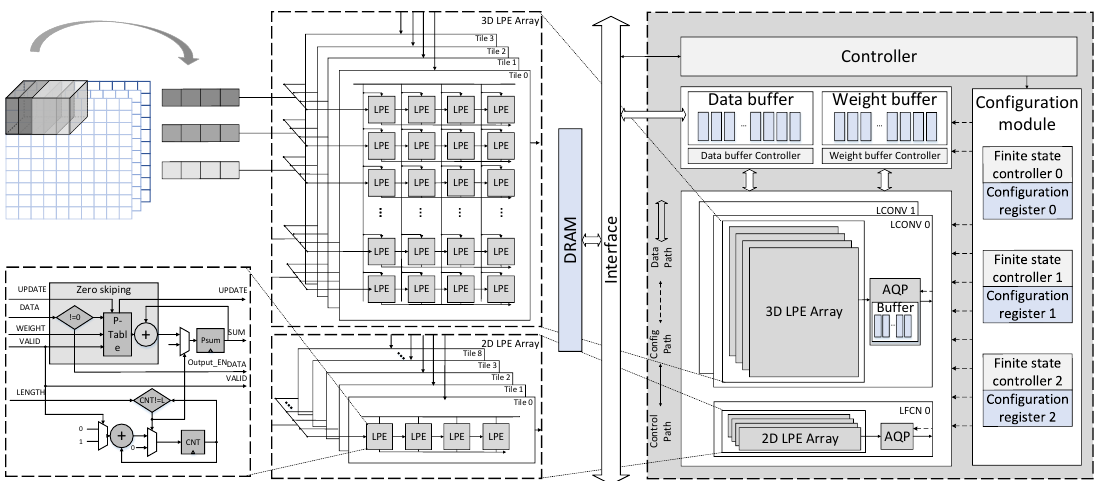
Figure 4. Overall architecture, systolic-like computing arrays for CONV and FCN layers, and